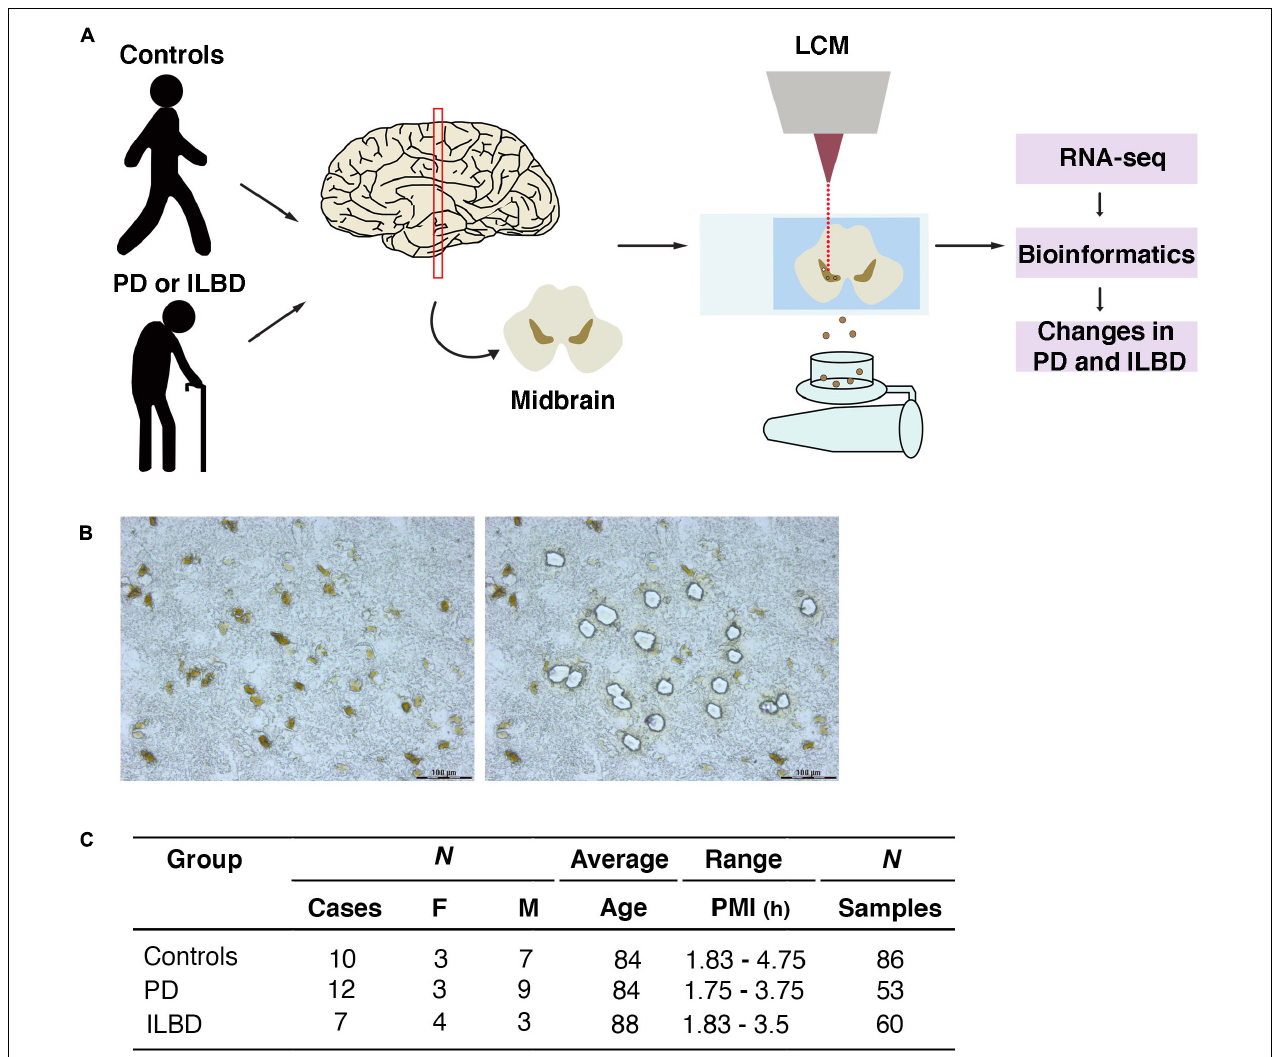
FIGURE 1 | LCM and RNA-seq analysis of mDA neurons from postmortem cases of Parkinson’s disease, incidental Lewy body disease and age-matched controls. (A) Schematic overview of experimental design. Midbrain sections were used to isolate neuromelanin positive DA neurons by LCM and processed for RNA-seq. (B) Micrographs of ventral midbrain neuromelanin positive cells before and after LCM. (C) Parkinson’s disease, incidental Lewy body disease and control samples analyzed in the